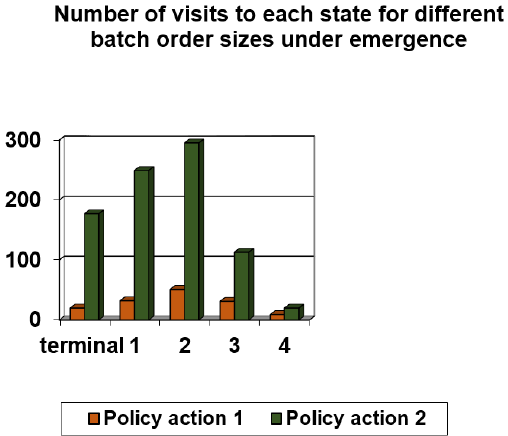
Figure 13. The number of agent visits to each state for the scheduling of one batch of 28 orders and four emergency orders, with mean order size three line items per order. The agent followed an ε-greedy policy with ε = 0.2.